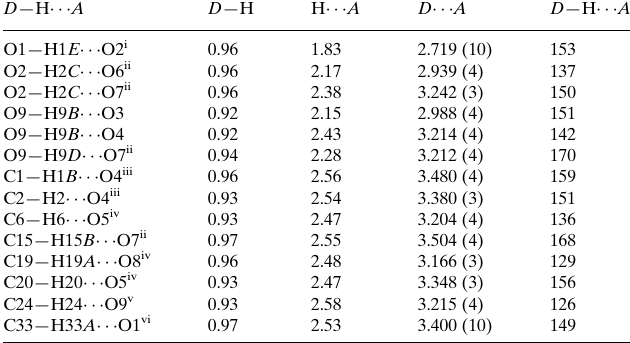
Hydrogen-bond geometry (A˚ , (cid:4)